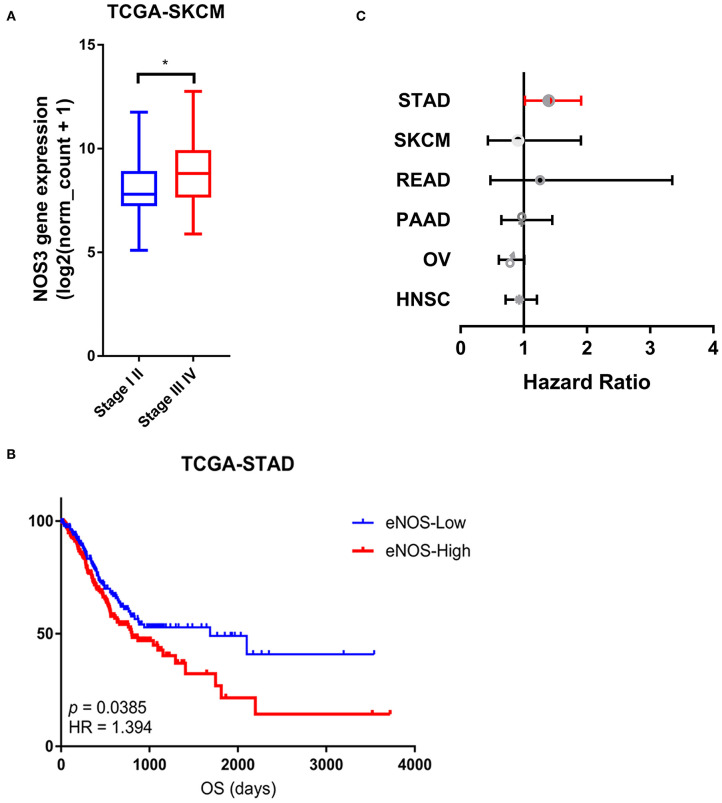
Association between NOS3 mRNA expression and clinical phenotypes. (A)
NOS3 expression between the early and advanced stages in SKCM. T-test was applied to analyses in the early stage and advanced stage. *p < 0.05. (B) The NOS3 expression level is related to overall survival in STAD. In the survival curves, the red line represents high NOS3 expression levels and the blue line represents low NOS3 expression levels. (C) A forest plot for survival association of each cancer is shown. The X-axis is the HR, the small points are the estimate of HR for each tumor and the bar represents the 95% confidence interval. Cox proportional hazards models were used to evaluate the association of NOS3 expression levels on overall survival.